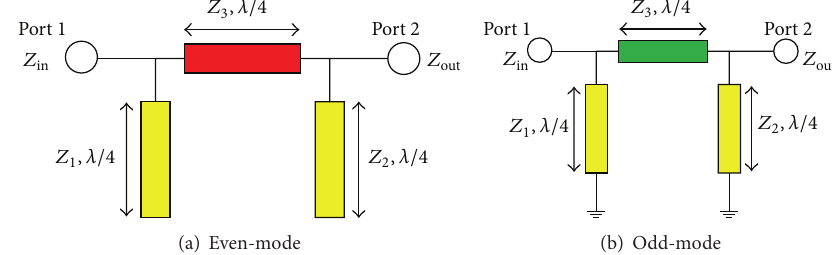
Figure 4: Even- and odd-mode analysis of two-section half-wave balun.